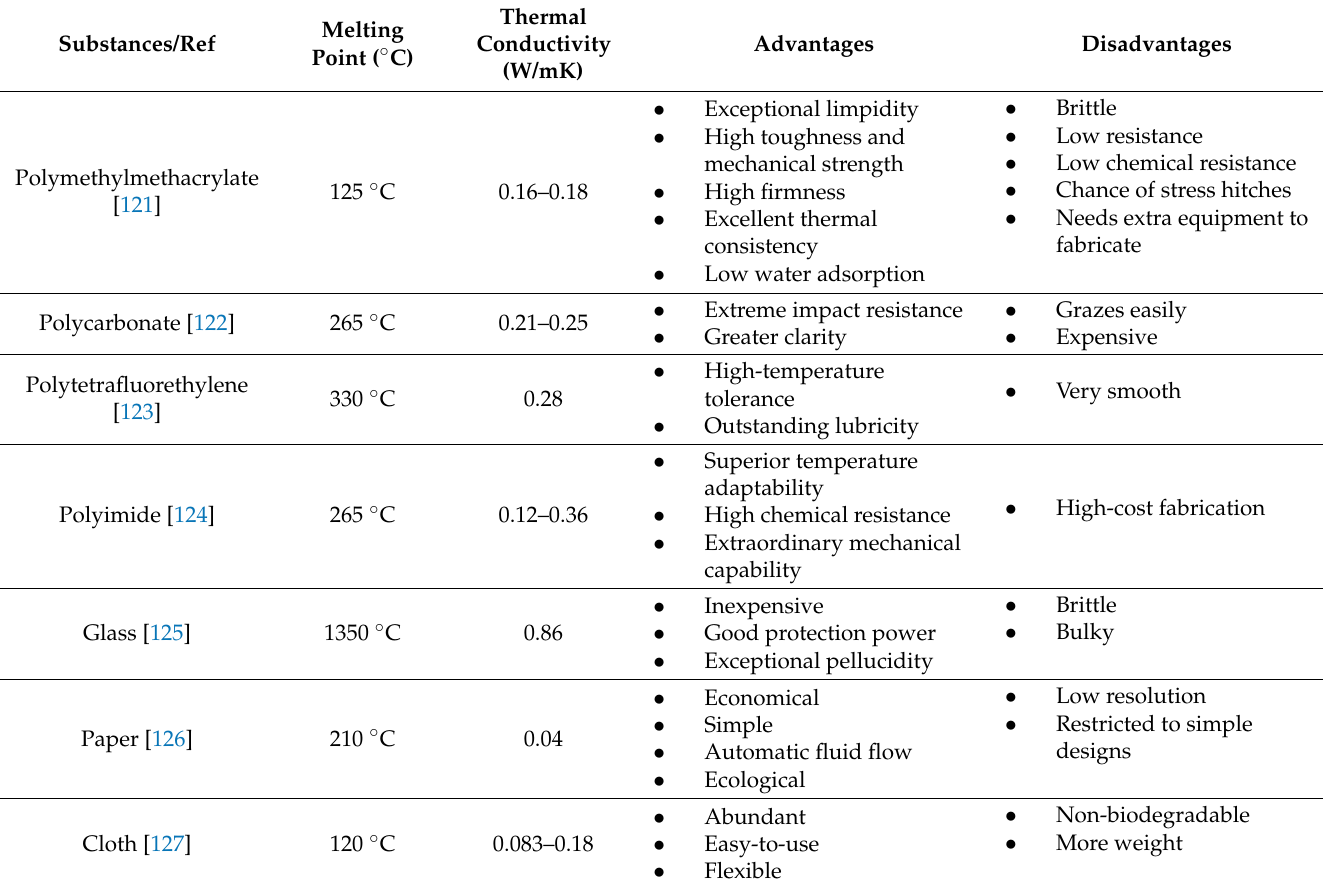
Table 5. Various substances used for the development of